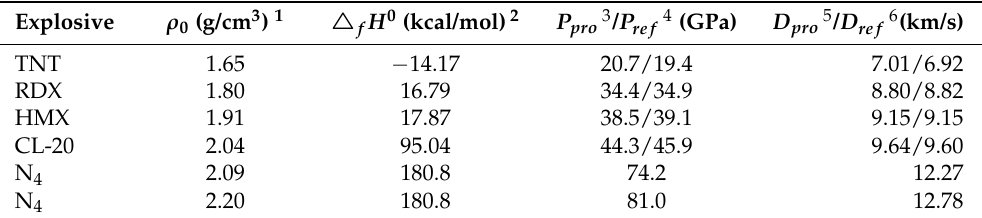
1 ρ 0 is the loading density of explosives.